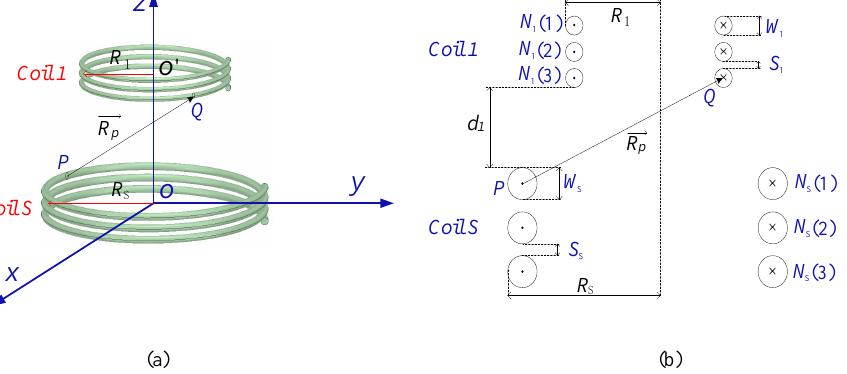
Figure 4. The diagrammatic sketch of perfectly aligned coils. ( a ) is the diagrammatic sketch. ( b ) is the cross section diagram of ( a